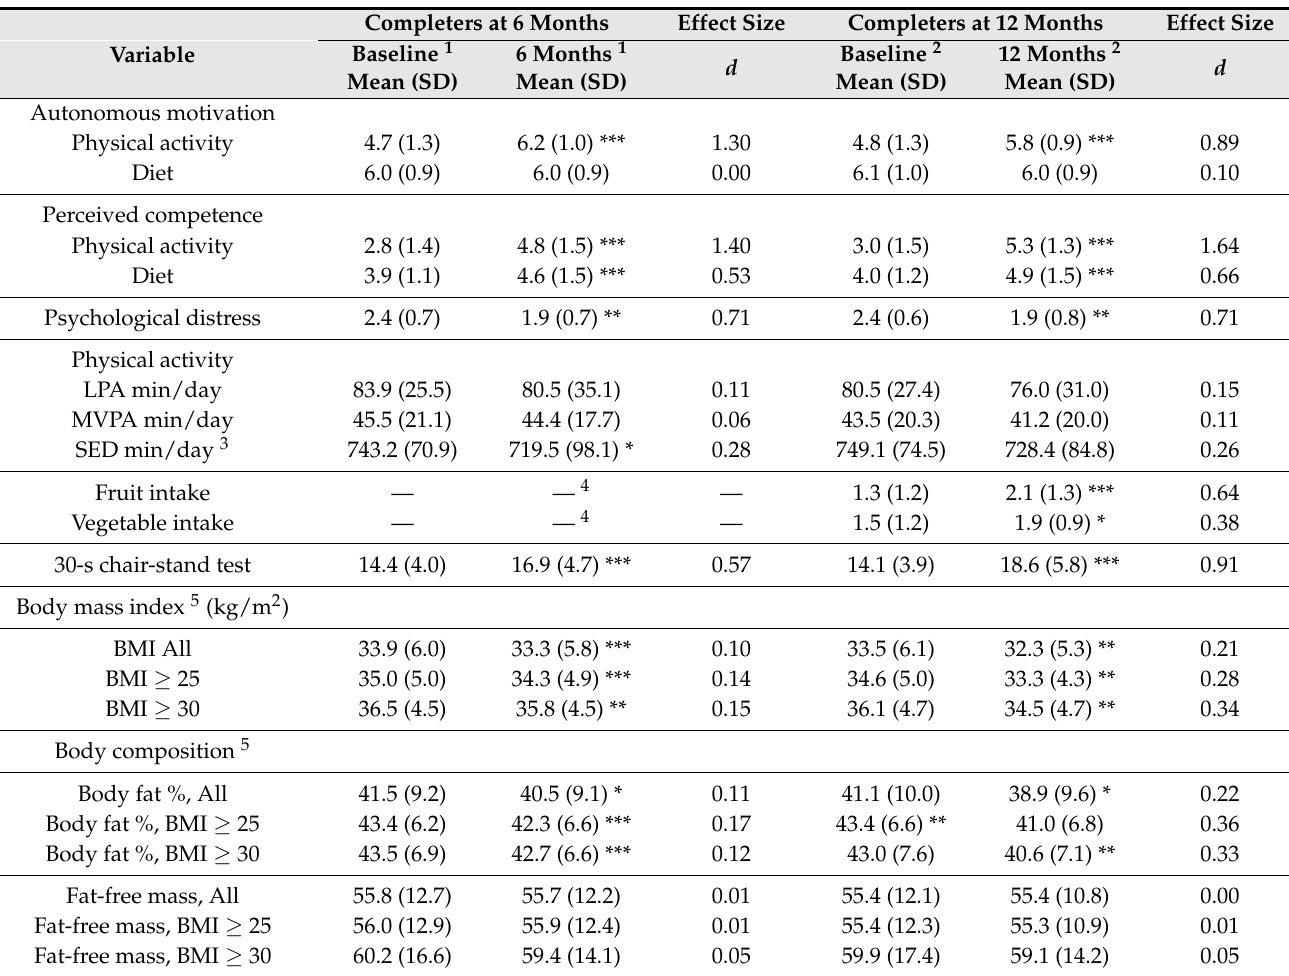
Table 3. Means and standard deviations for the study variables at baseline, 6 months, and 12